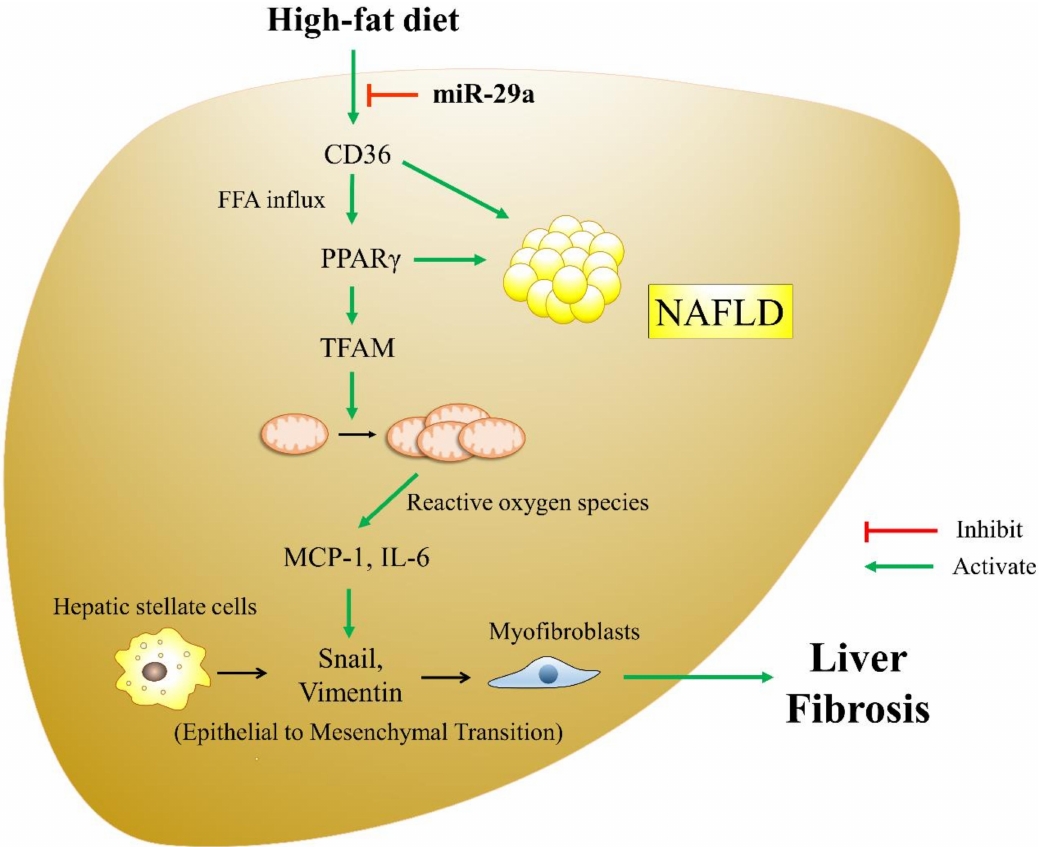
Figure 8. The proposed model of miR-29a exerting a protective e ff ect by targeting CD36 and